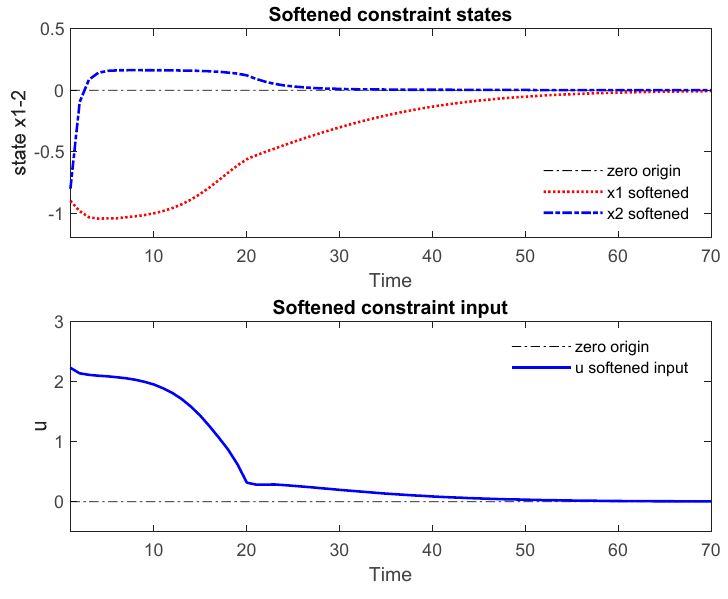
Figure 5. Softened constraint NMPC.